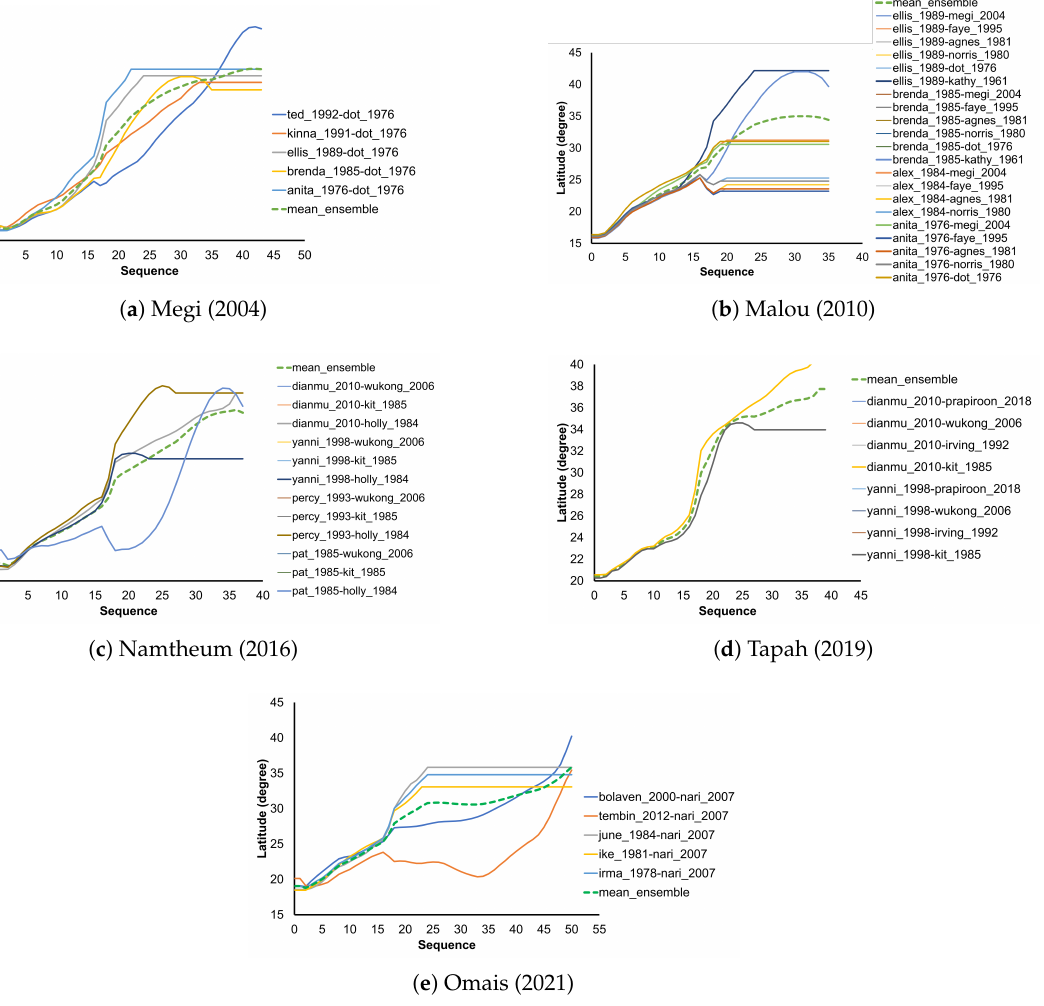
Figure 10. Typhoon track prediction for the meridional component: ( a ) Megi 2004, ( b ) Malou